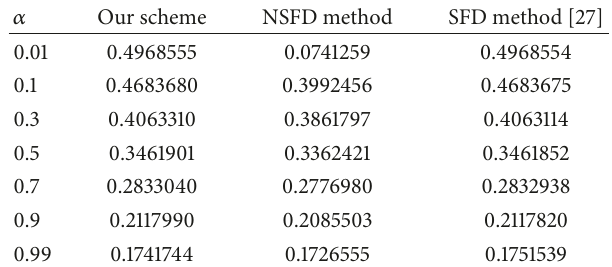
Table 3: Maximum norm relative errors of the proposed approxi- mate-analytical solution, NSFD method, and SFD technique for Example 5.